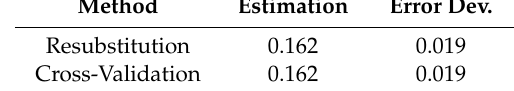
Table 11. Classification success for using Twitter.